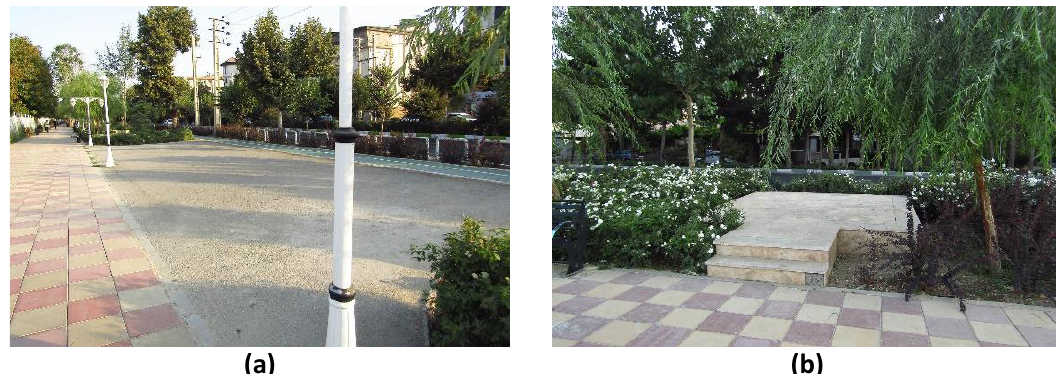
Fig. 11: (a) An opening in the space, suitable for gatherings and sporting activities; (b) A public stone platform